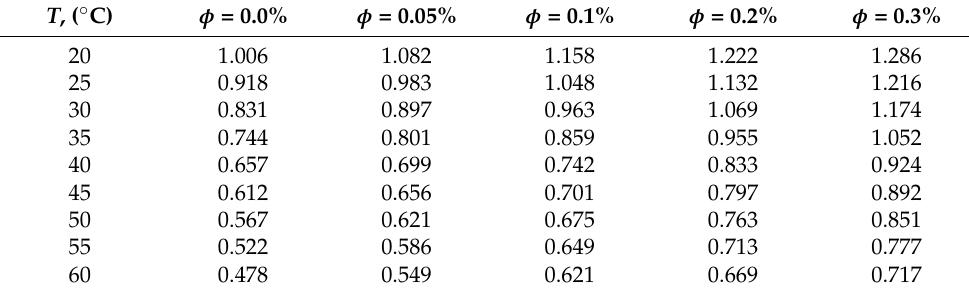
Table 3. Viscosity of hybrid nanofluids.